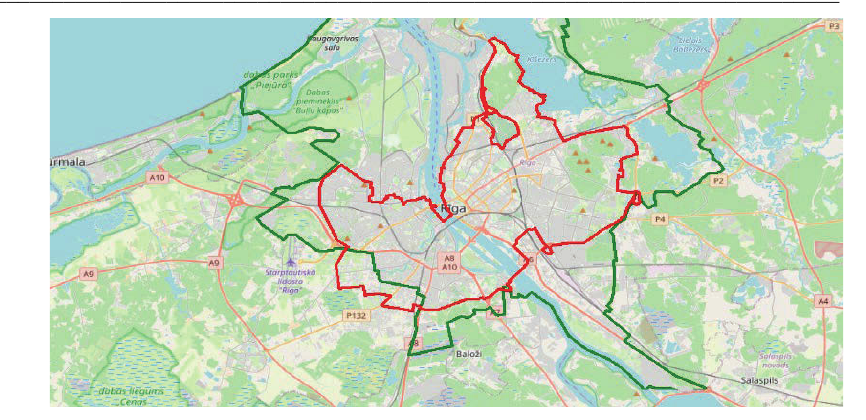
Fig. 1. The scooter coverage